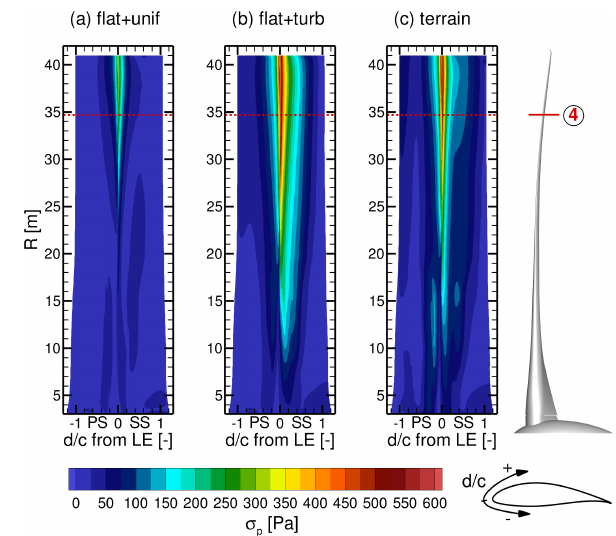
Figure 22. Standard deviation σ of surface pressure p on one blade for all cases (a) – (c) .